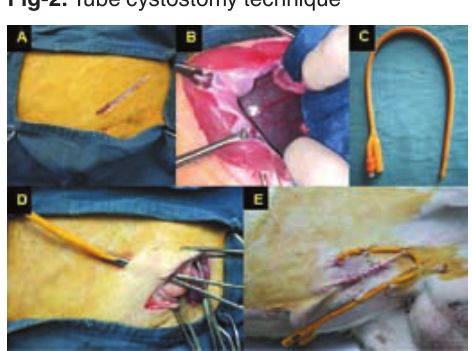
Fig-2. Tube cystostomy